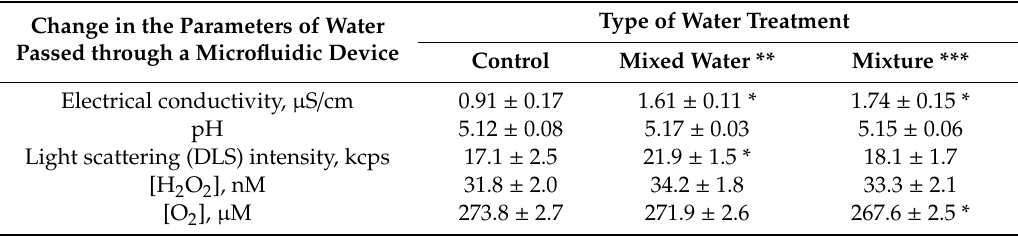
Table 2. Changes in the physicochemical parameters of water passed through a microfluidic device under non-mixing or mixing